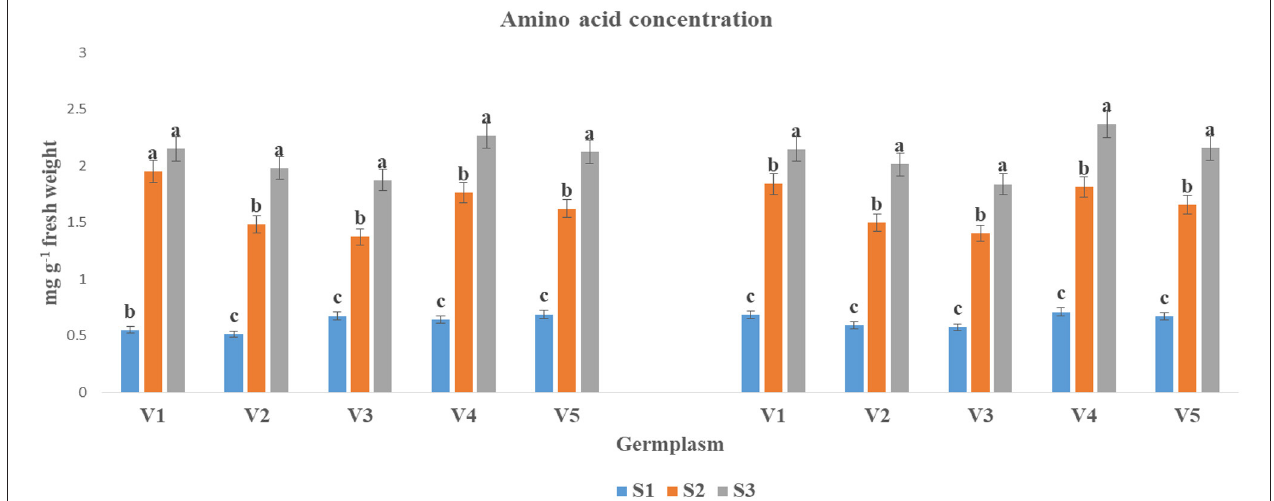
FIGURE 3 | The AA concentration (mg g − 1 fresh weight) at mid-flowering stage in top leaf of mustard varieties sown at three different dates during rabi 2017–2018 and 2018–2019. Different date of sowing represented as S1 timely sown (30 October), S2 late sown (15 November), and S3 very late sown (30 November); Varieties symbolize with: V1, PM 25; V2, PM 26; V3, BPR-541-4; V4, RH-406; and V5, Urvashi, respectively. The mean value ± p ≤ 0.05 error bar data were presented in the figure and different alphabetical letters indicate the significant difference for each variety under different date of sowing ( p ≤ 0.05).